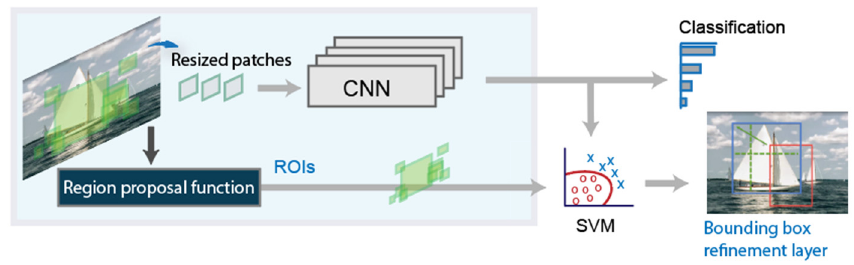
Figure 1. Basic schema of the RCNN detector.